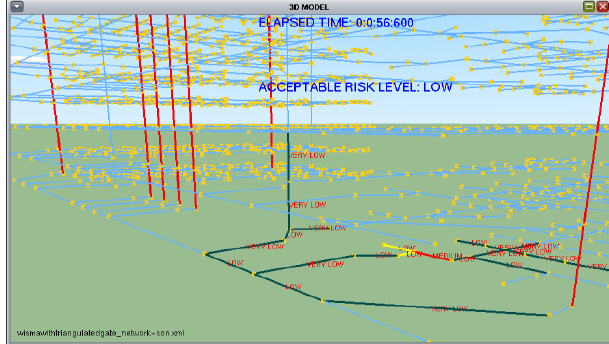
Figure 8. Evacuation scenario (Scene-1).